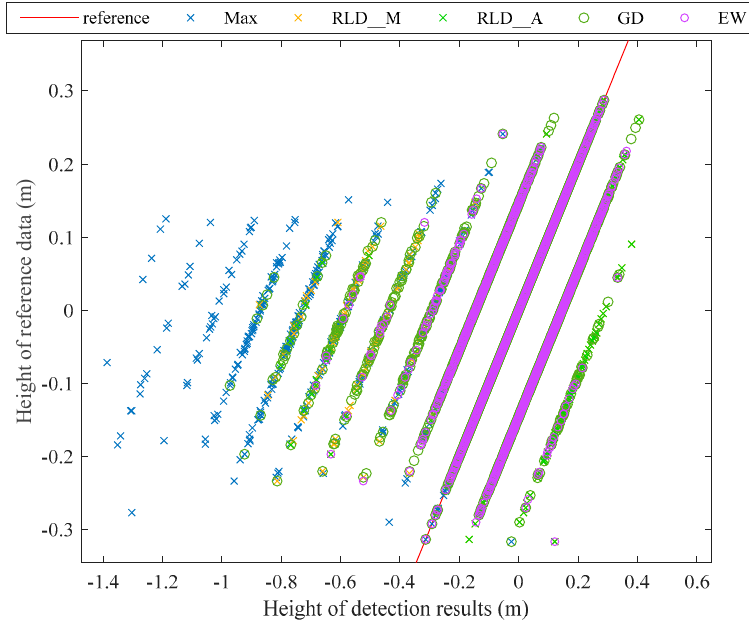
Figure 15. Comparison between the height of the water surface in reference data and detection results.